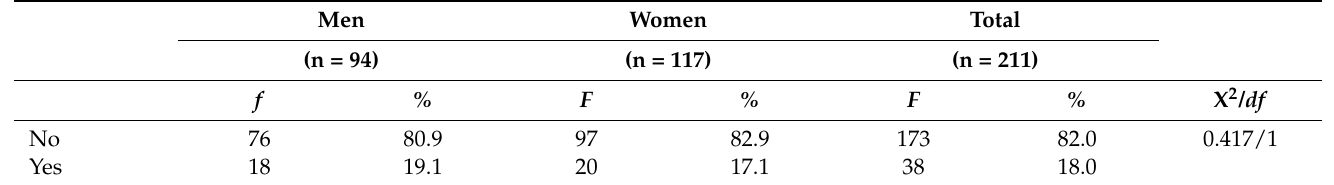
Table 3. Have you suffered discrimination because of your religious beliefs or sexual practices or